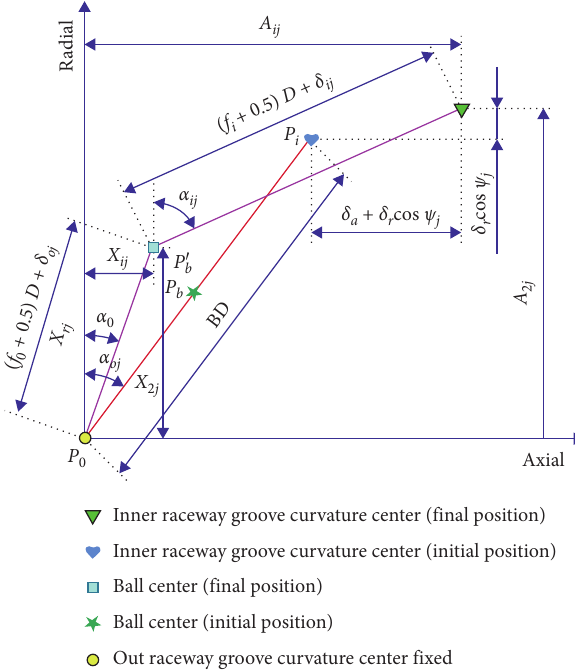
Figure 3: Schematic diagram of the change of the center position of the groove before and after the